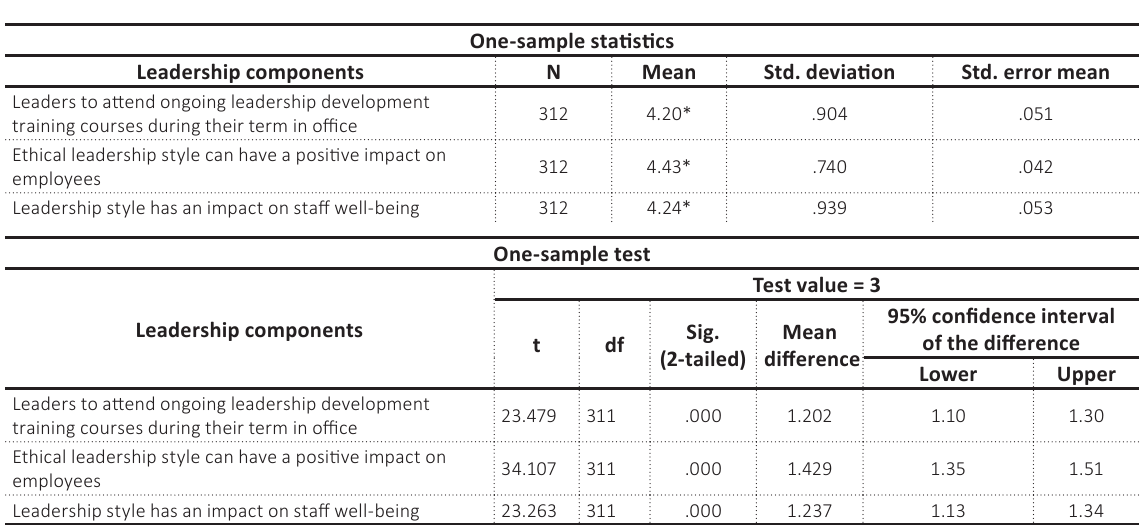
Table 2. One-sample test and one-sample statistics for three